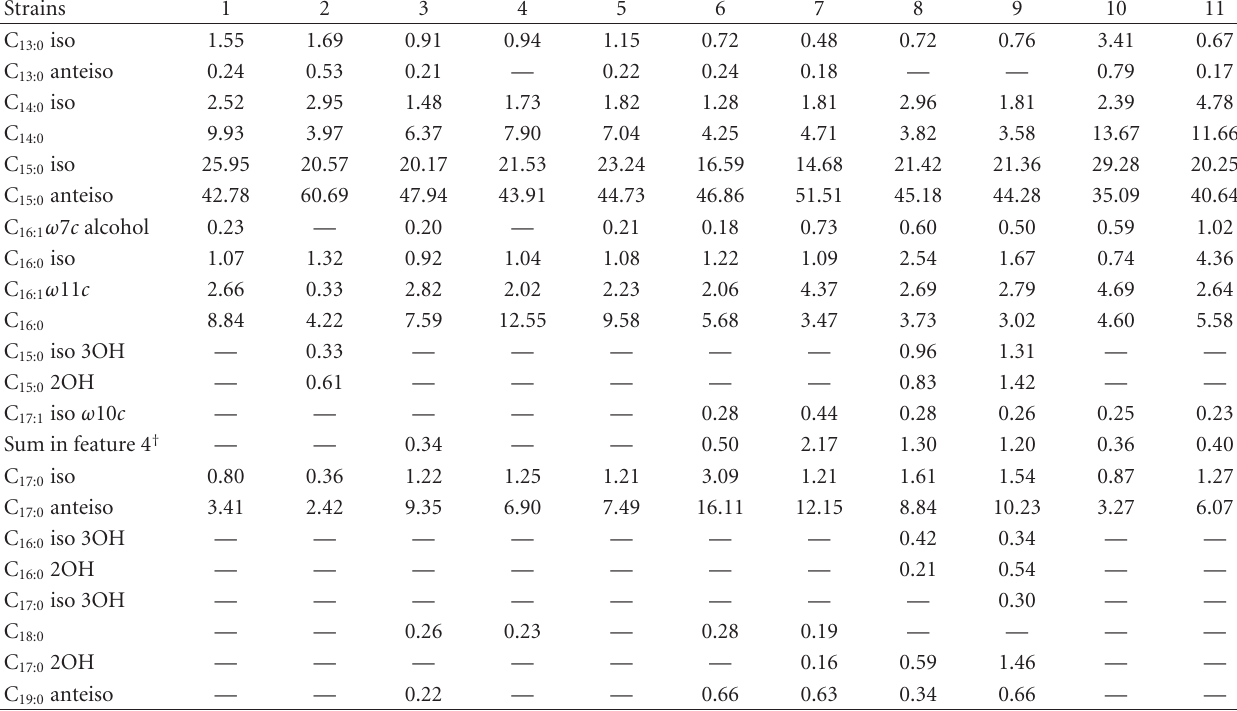
Table 3: Comparison of percent cellular fatty acid content between strain CBD 118, eight closely related strains, and most closely related type strains. 1: CBD 118; 2: OSS 25; 3: P307; 4: P308; 5: C4T1F3B3; 6: IAFILS6; 7: AD5A; 8: U4A; 9: ADP4II; 10: Bacillus nealsonii DSM